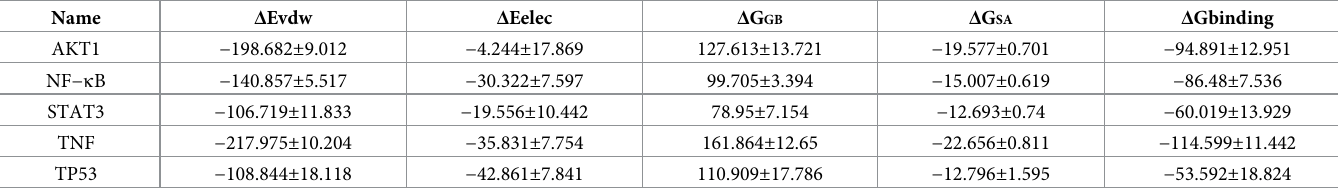
Table 3. The binding free energy by MMGBSA